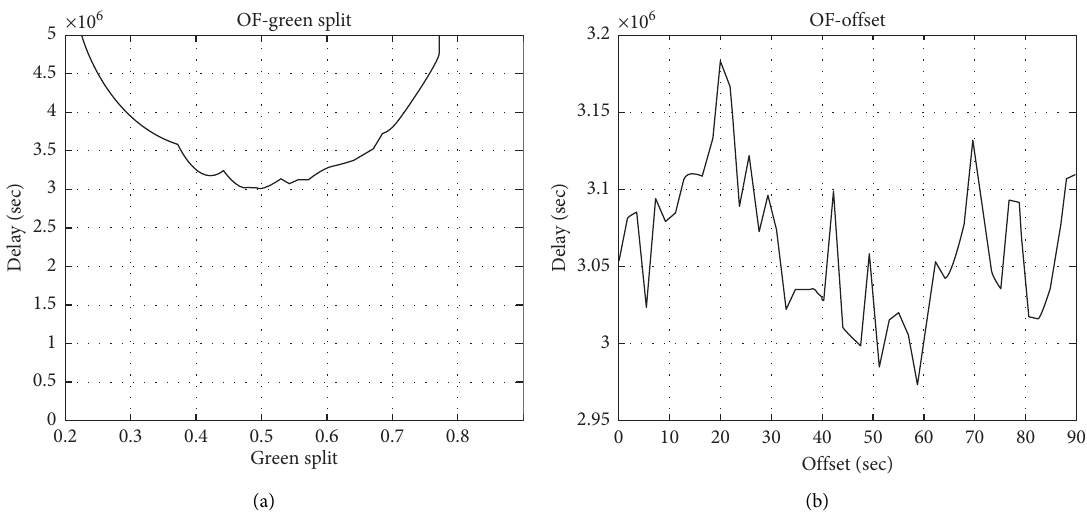
Figure 2: Shape of the objective